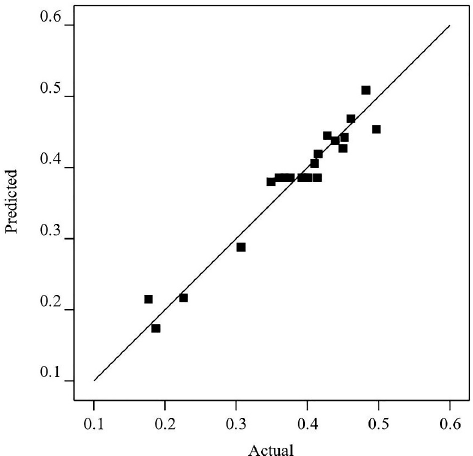
Figure 11. Predicted values versus actual values of IV SC .